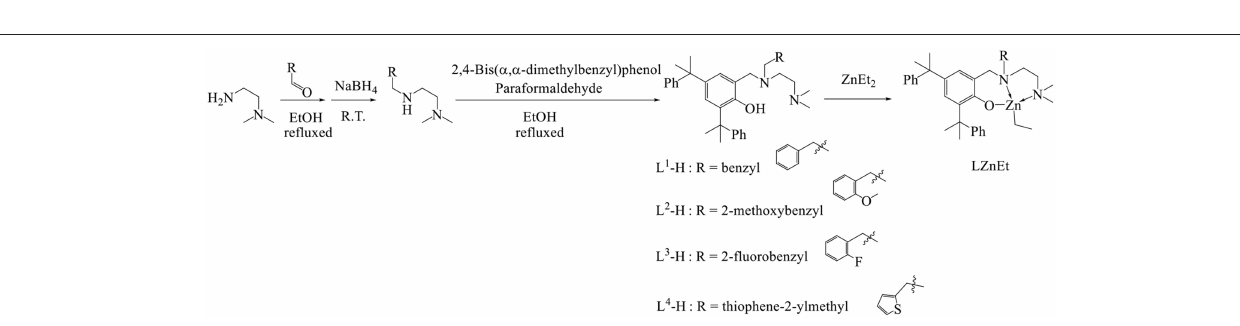
FIGURE 2 | Synthesis of the ligands L 1 -H–L 4 -H and associated Zn complexes.